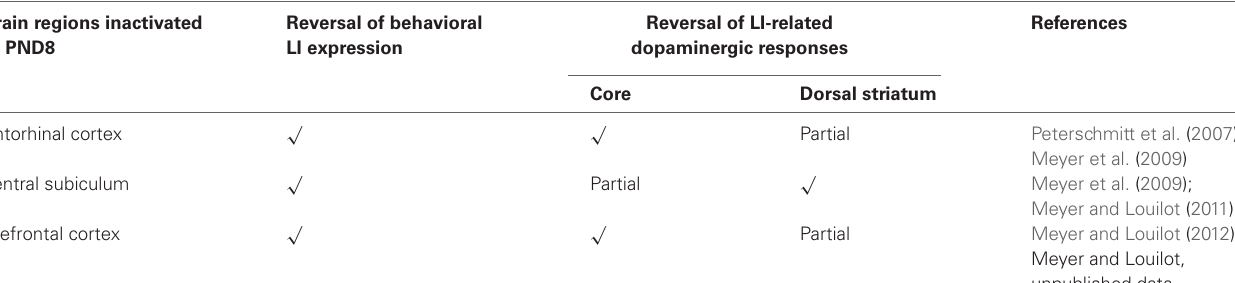
Table 1 | Summary of the main results obtained at the behavioral and neurochemical level following neonatal TTX inactivation of the entorhinal cortex, the ventral subiculum or the prefrontal cortex. Brain regions inactivated at